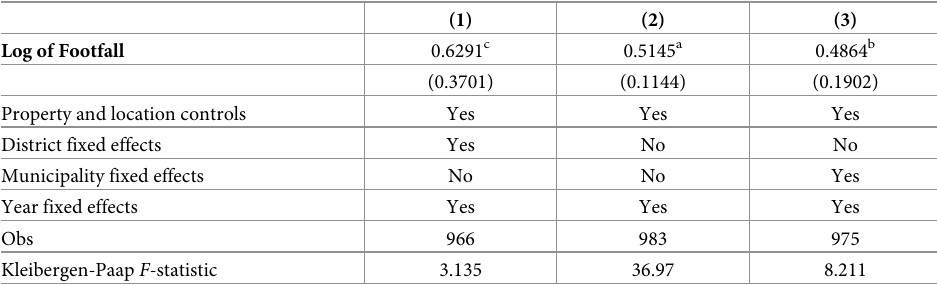
Table 3. The impact of footfall on retail